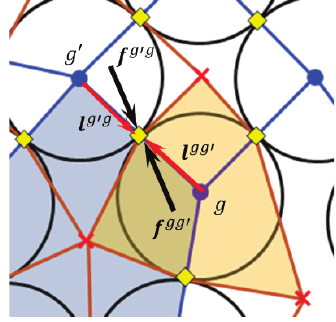
Fig. 1. Cell structure defined in this study.